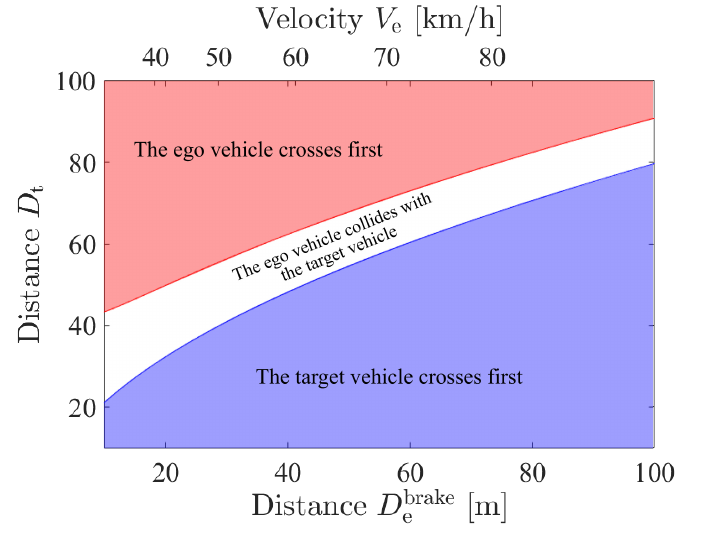
Figure 3. The visualized three driving patterns at V t = 80 km/h with comfortable